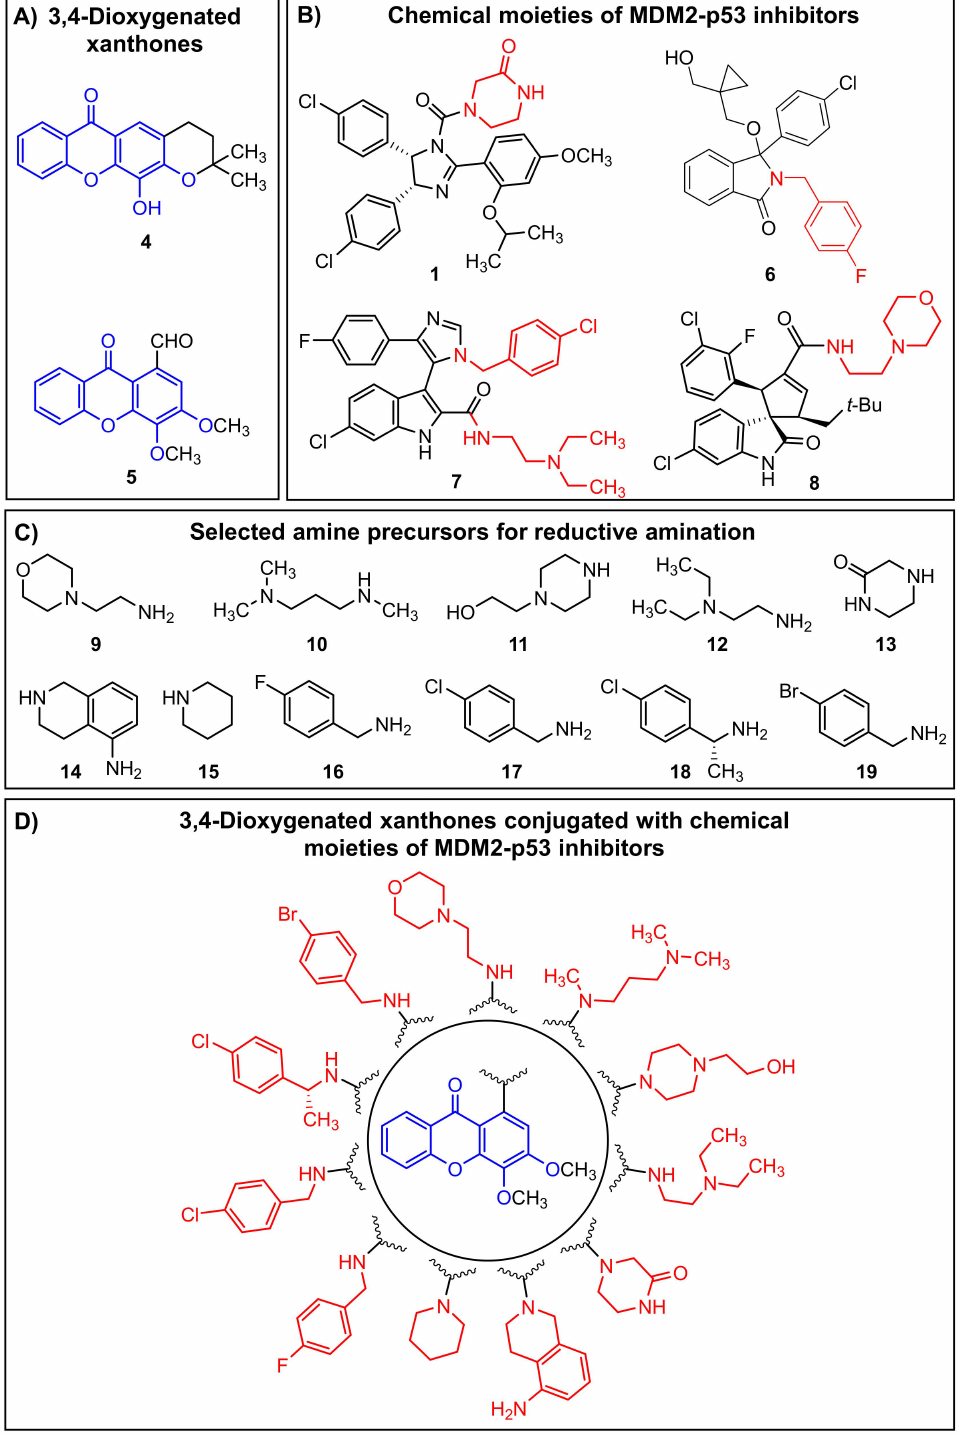
Figure 2. Strategy of molecular hybridization used for the construction of the library of aminated xanthones ( D ) by conjugation of the 3,4-dioxygenated substitution pattern of xanthones 4 and 5 ( A ) with the chemical moieties of known murine double minute 2 (MDM2)-p53 inhibitors ( C ), namely the molecules 1 (IC 50 = 0.09 µ M) , 6 (IC 50 = 2.6 µ M) , 7 (K I = 0.656 µ M), and 8 (K I = 0.023 µ M) ( B